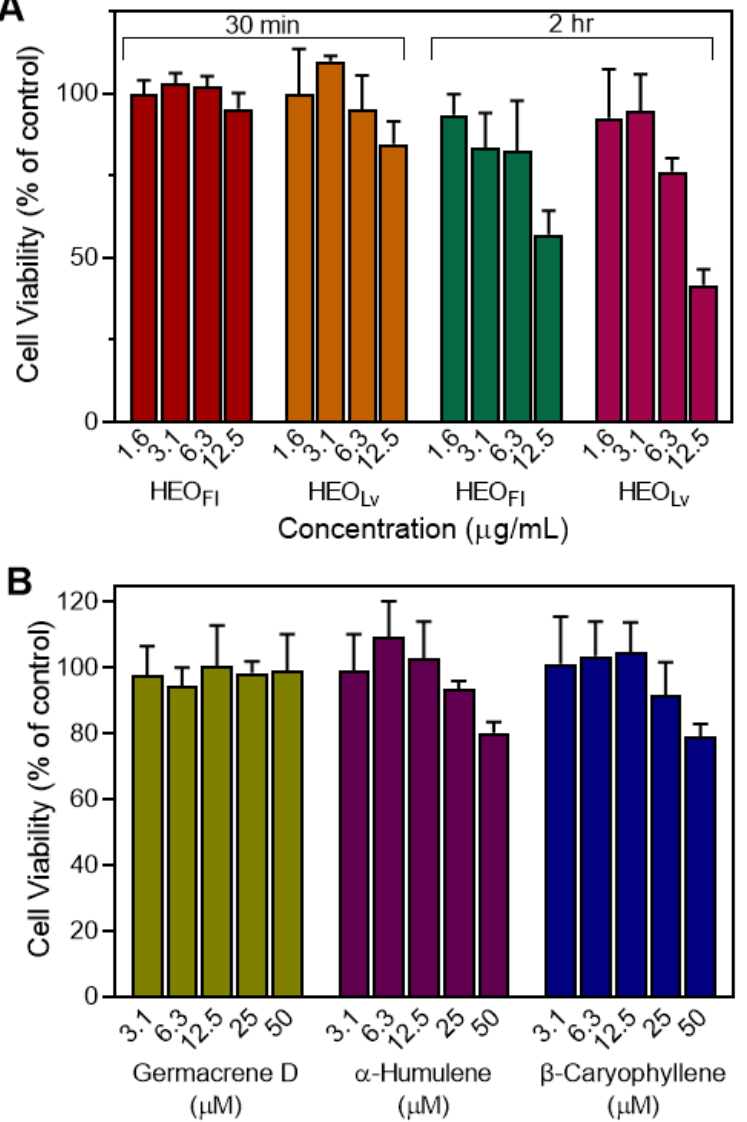
Figure 7. Cytotoxicity of HEO Lv , HEO Fl , and selected sesquiterpenes. HL-60 cells were preincubated with HEO Lv or HEO Fl for 30 min and 2 h ( A ) or with the indicated pure compounds for 2 h ( B ), and cell viability was analyzed as described. The data are presented as the mean ± S.D. (N = 3) from one experiment that is representative of two independent experiments.